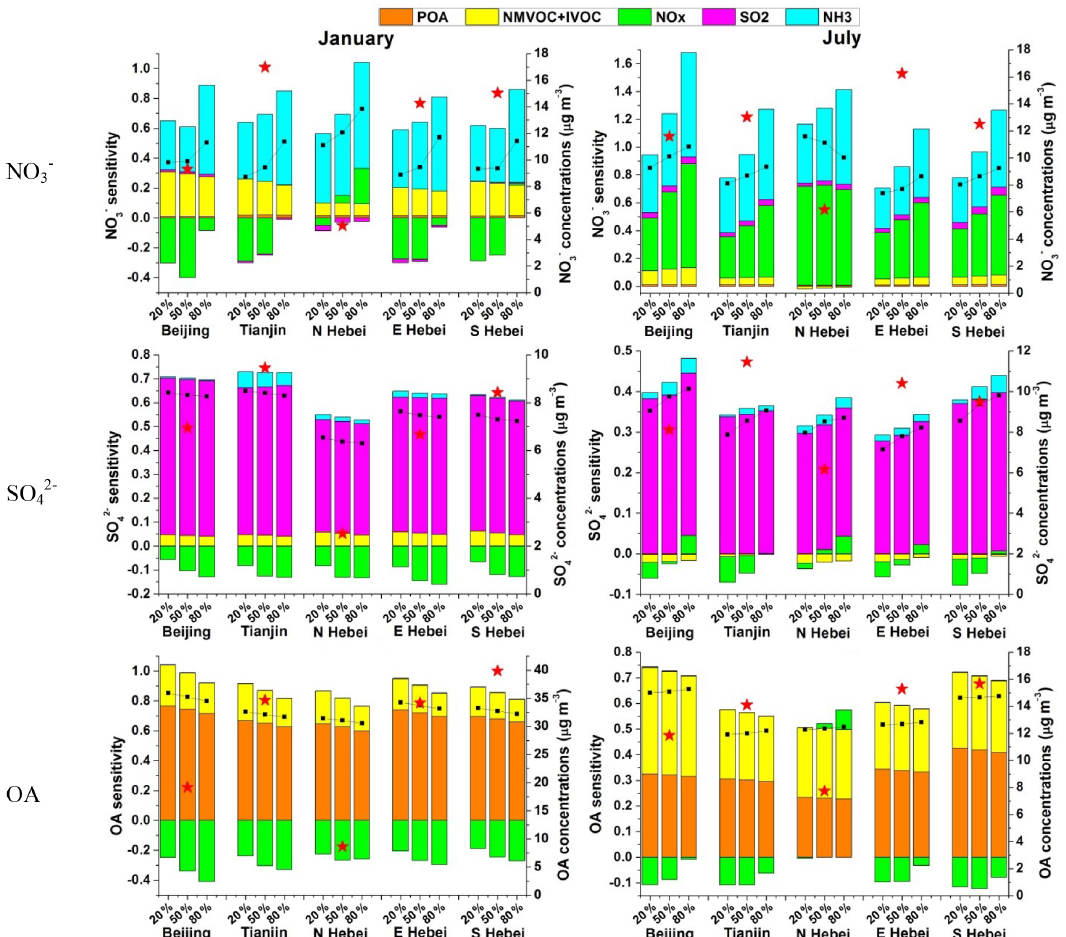
Figure 7. Sensitivity of monthly mean NO − July. The meanings of x axis, y axis, colored bars, black dotted lines, and red stars are the same as in Fig. 4 but for NO − results for March and October are given in Fig.